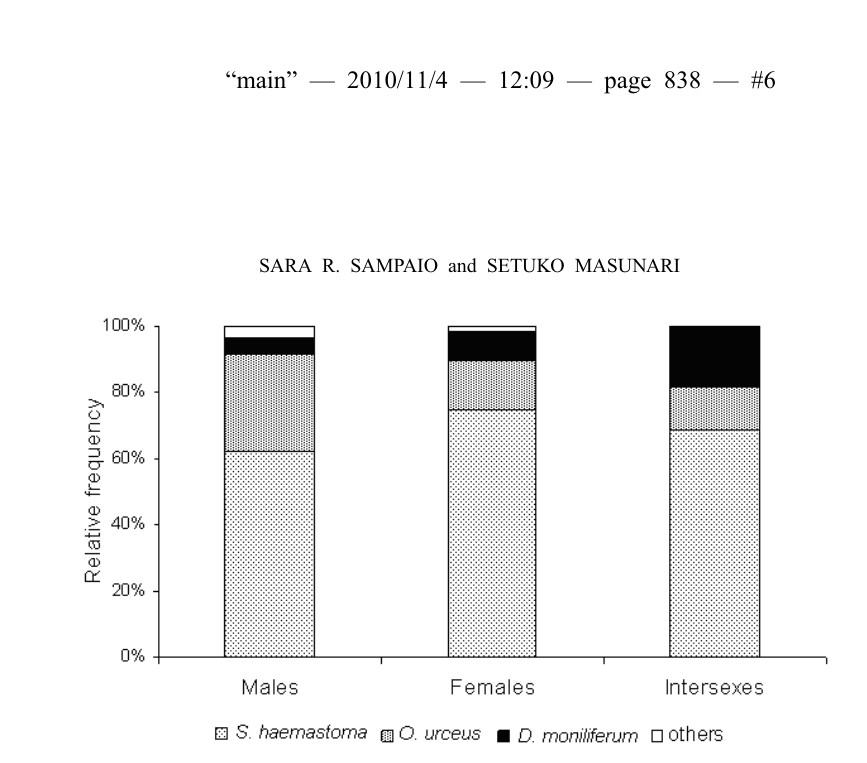
Fig. 3 – Clibanarius vittatus . Relative frequencies of occupied shells by males, females and